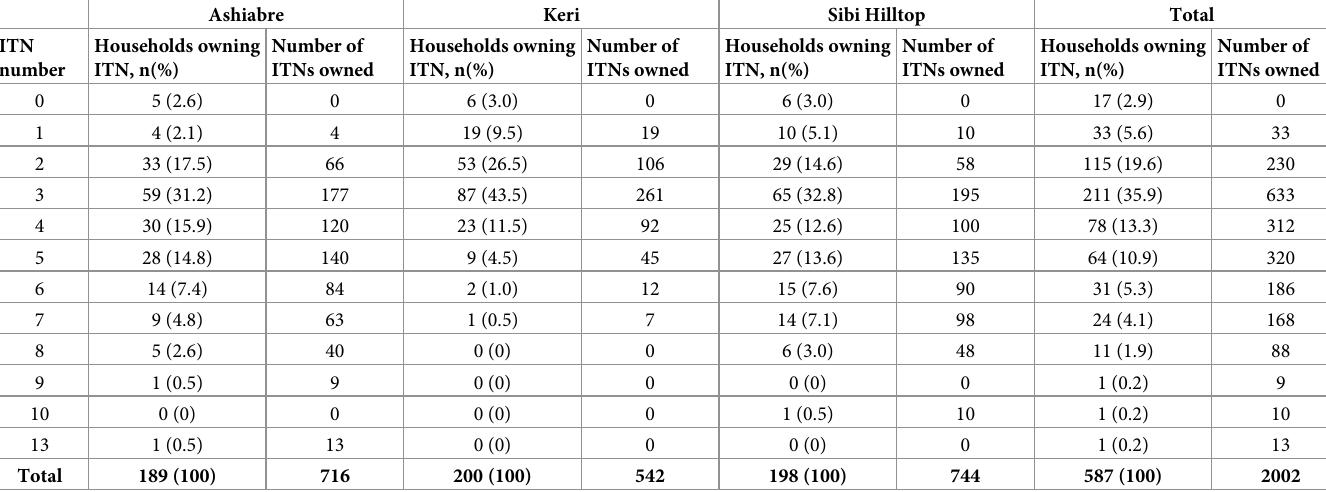
Table 4. Number of ITNs owned by